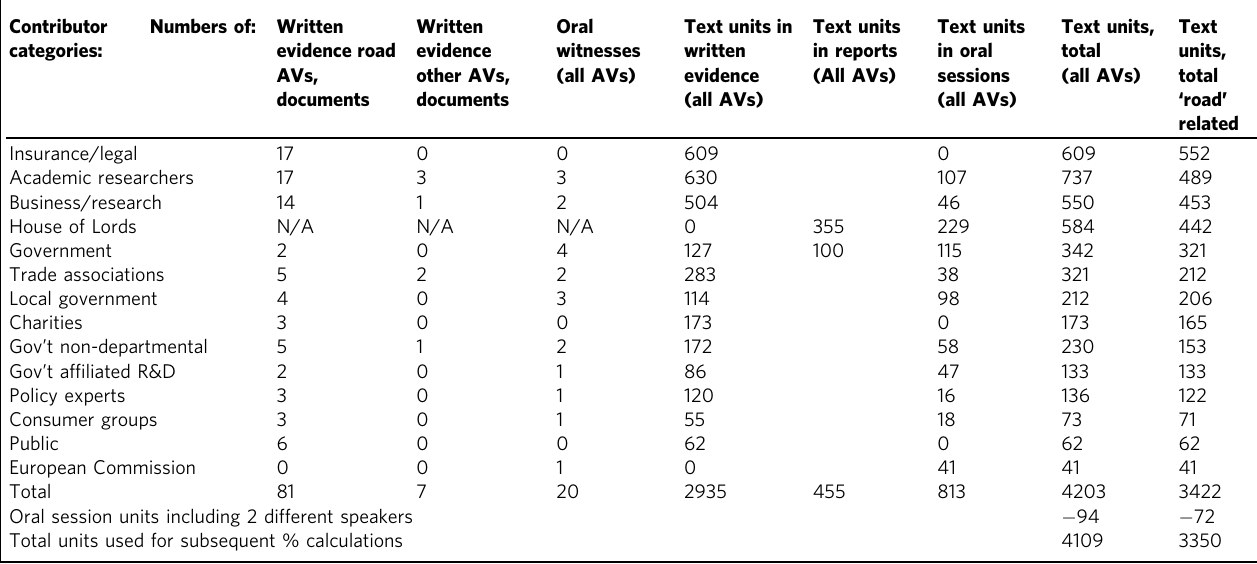
Table 2 Contributors to the Inquiry 6 .